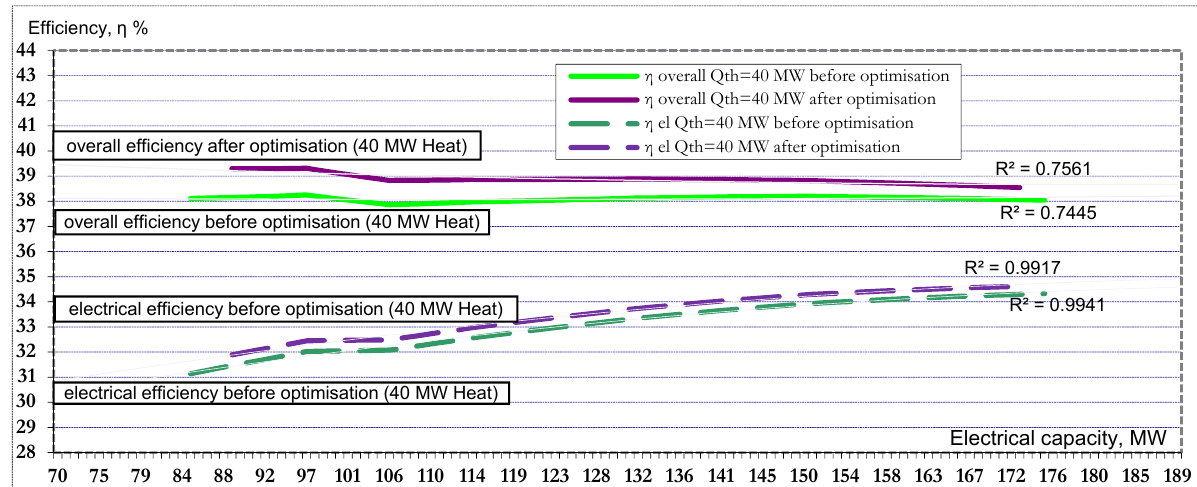
Figure 10. Efficiency optimisation result for minimum 40 MW heat demand.